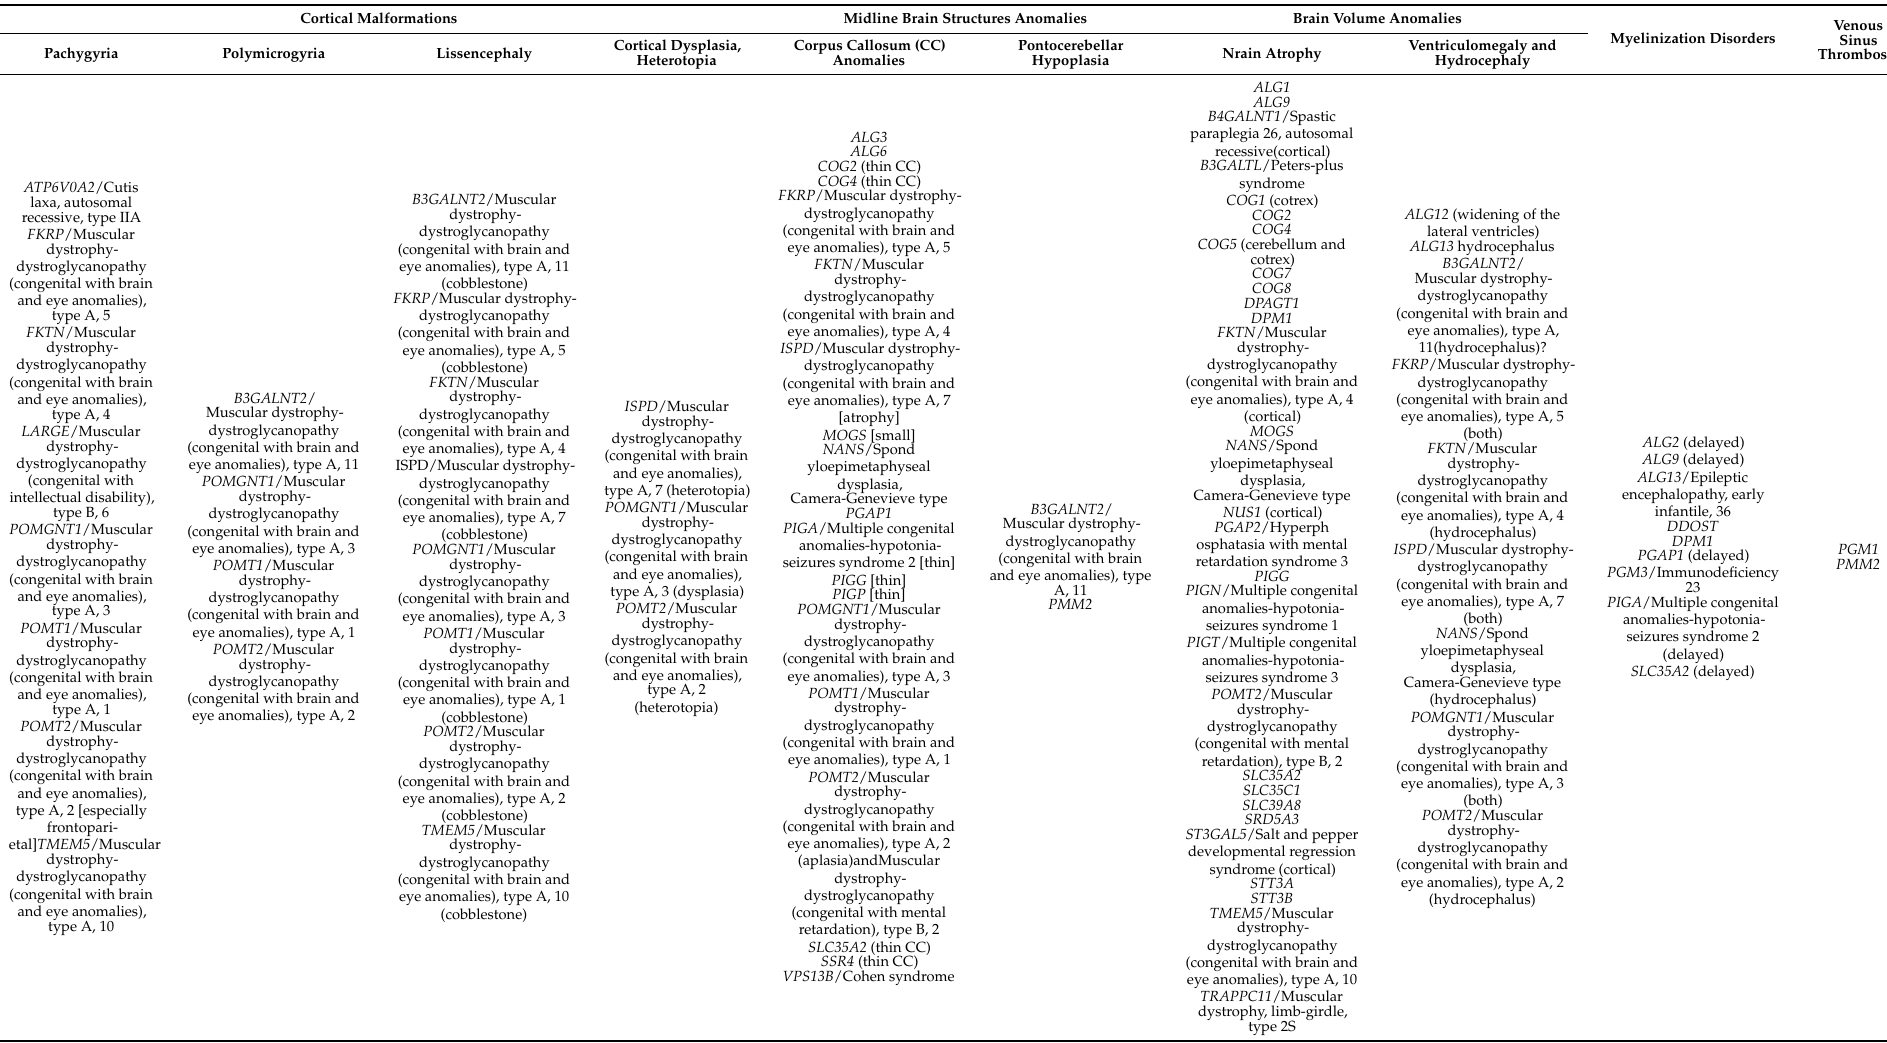
Table 2. Brain malformations, anomalies and cerebral complications characteristic for specific CDG (the names of the diseases are given following the Online Mendelian Inheritance in Man ® , OMIM nomenclature